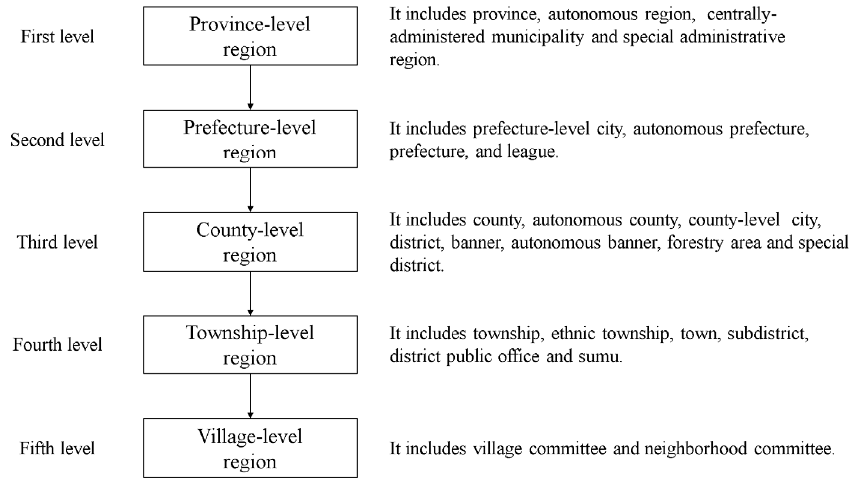
Figure 1. Chinese administrative territorial hierarchy (Source: by the authors).